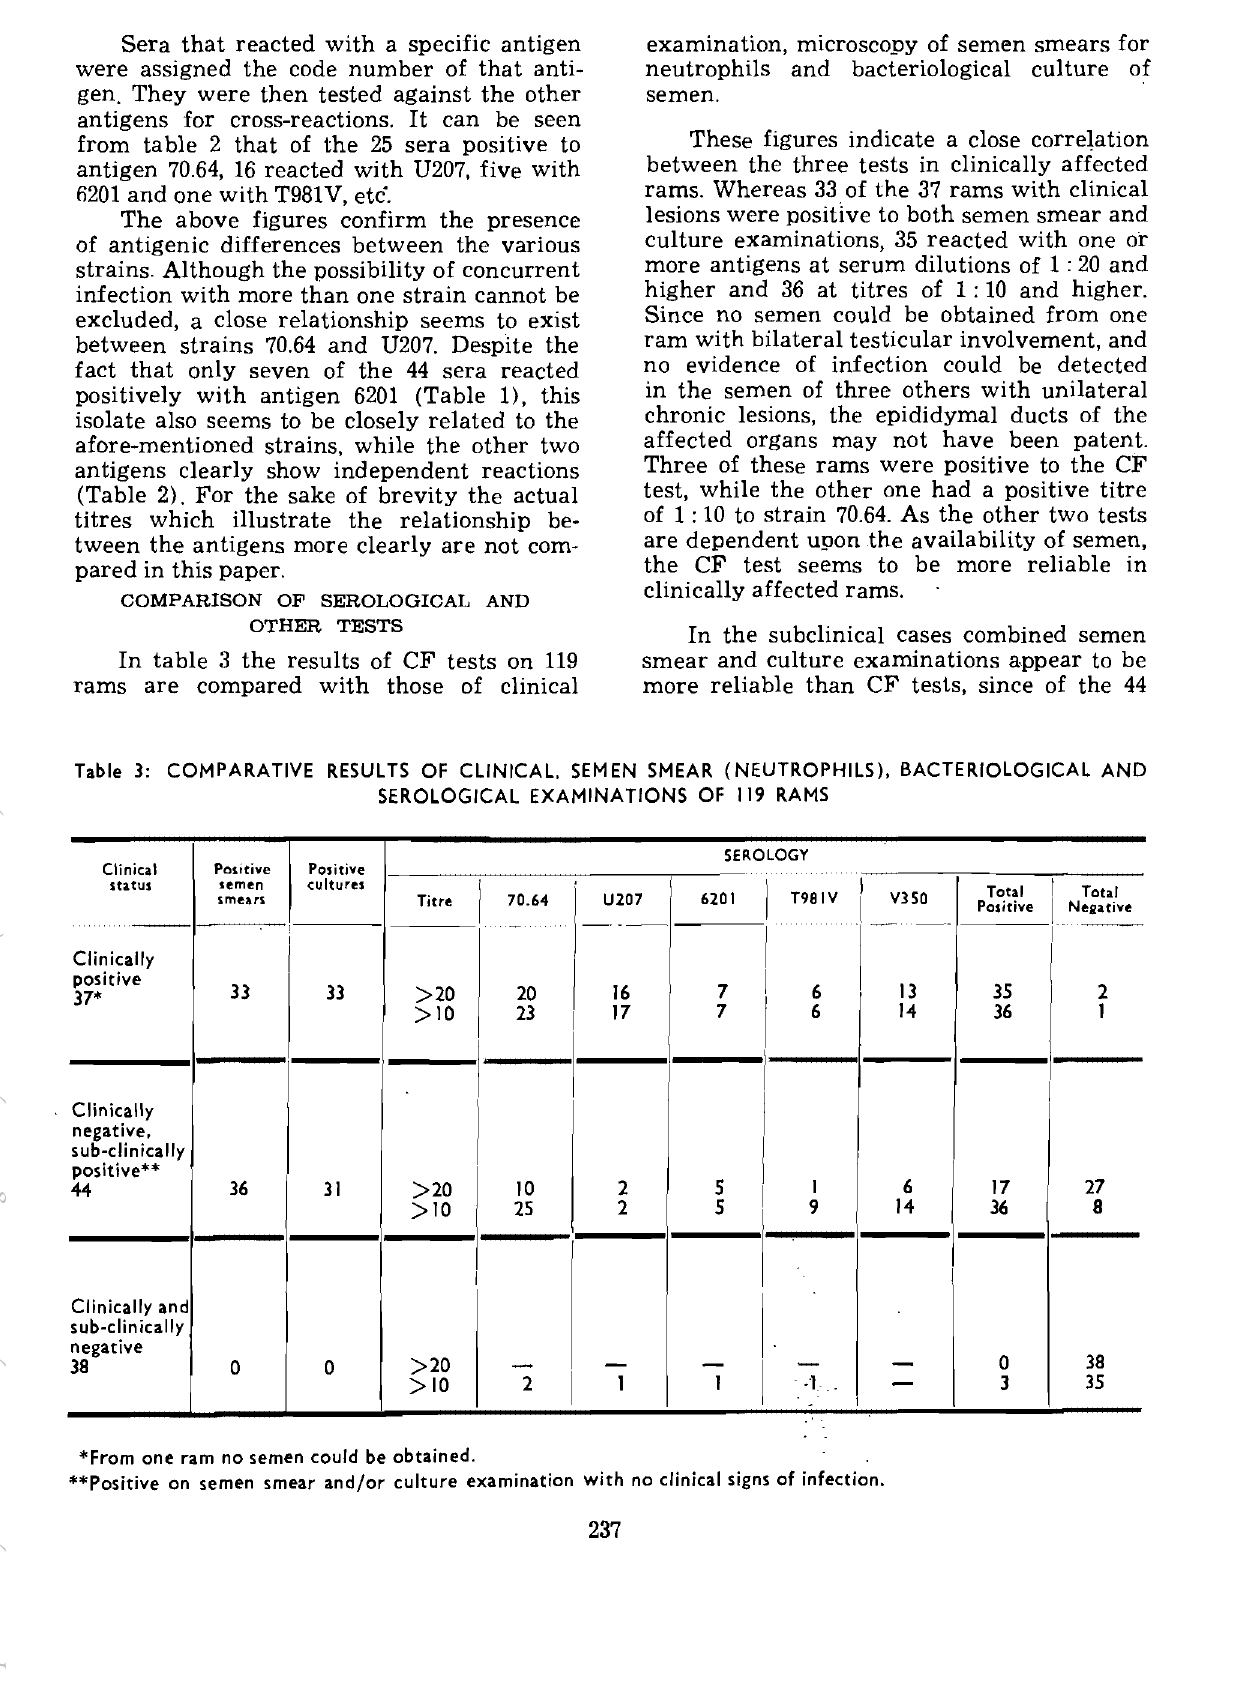
Table 3: COMPARATIVE RESULTS OF CLINICAL, SEMEN SMEAR (NEUTROPHILS), BACTERIOLOGICAL